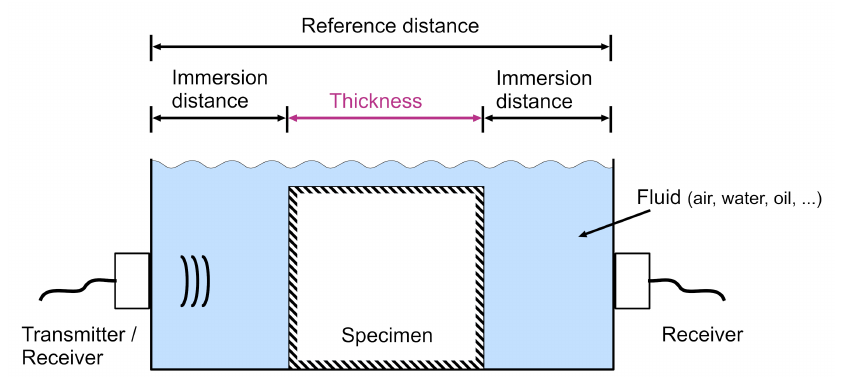
Figure 1. Sketch of a conventional immersed through-transmission setup for ToF measurement. The ToF through the specimen thickness is the target quantity. For an accurate measurement, knowl- edge of the transmitter characteristics and either the speed of sound in the immersion fluid and the immersion distances or the reference distance are